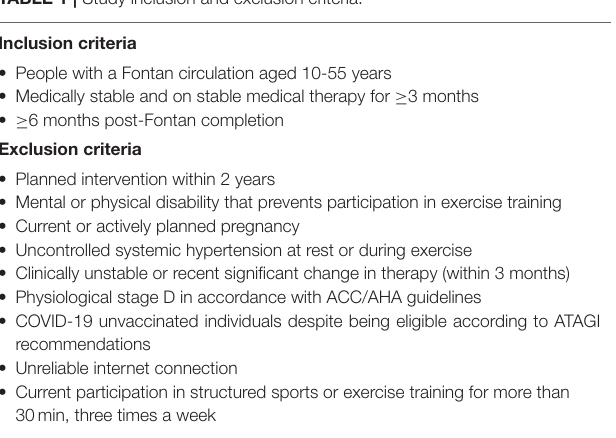
TABLE 1 | Study inclusion and exclusion